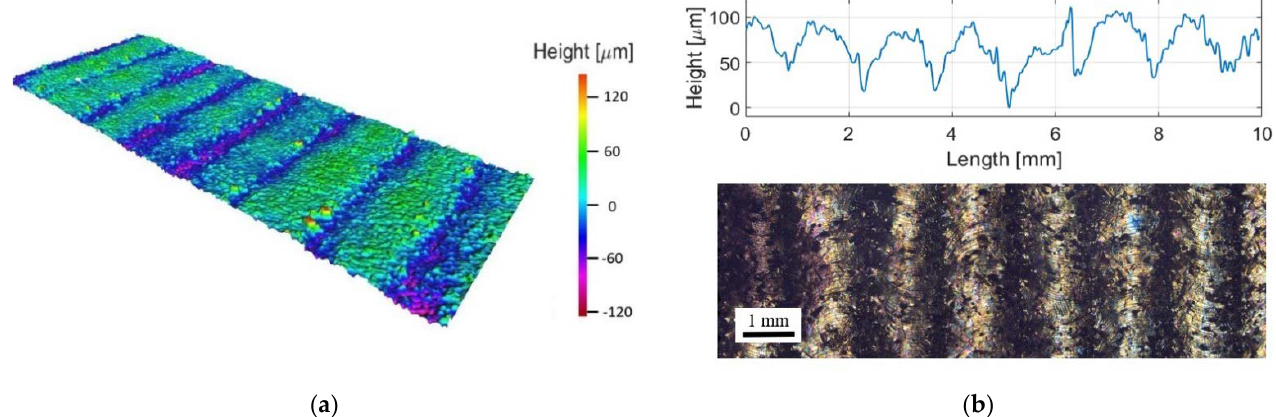
Figure 16. Surface morphology of RD 0.9 mm LMD sample: ( a ) LMD build surface morphology; ( b ) LMD track form with optical image showing unconsolidated powder particles in the grooves between tracks.